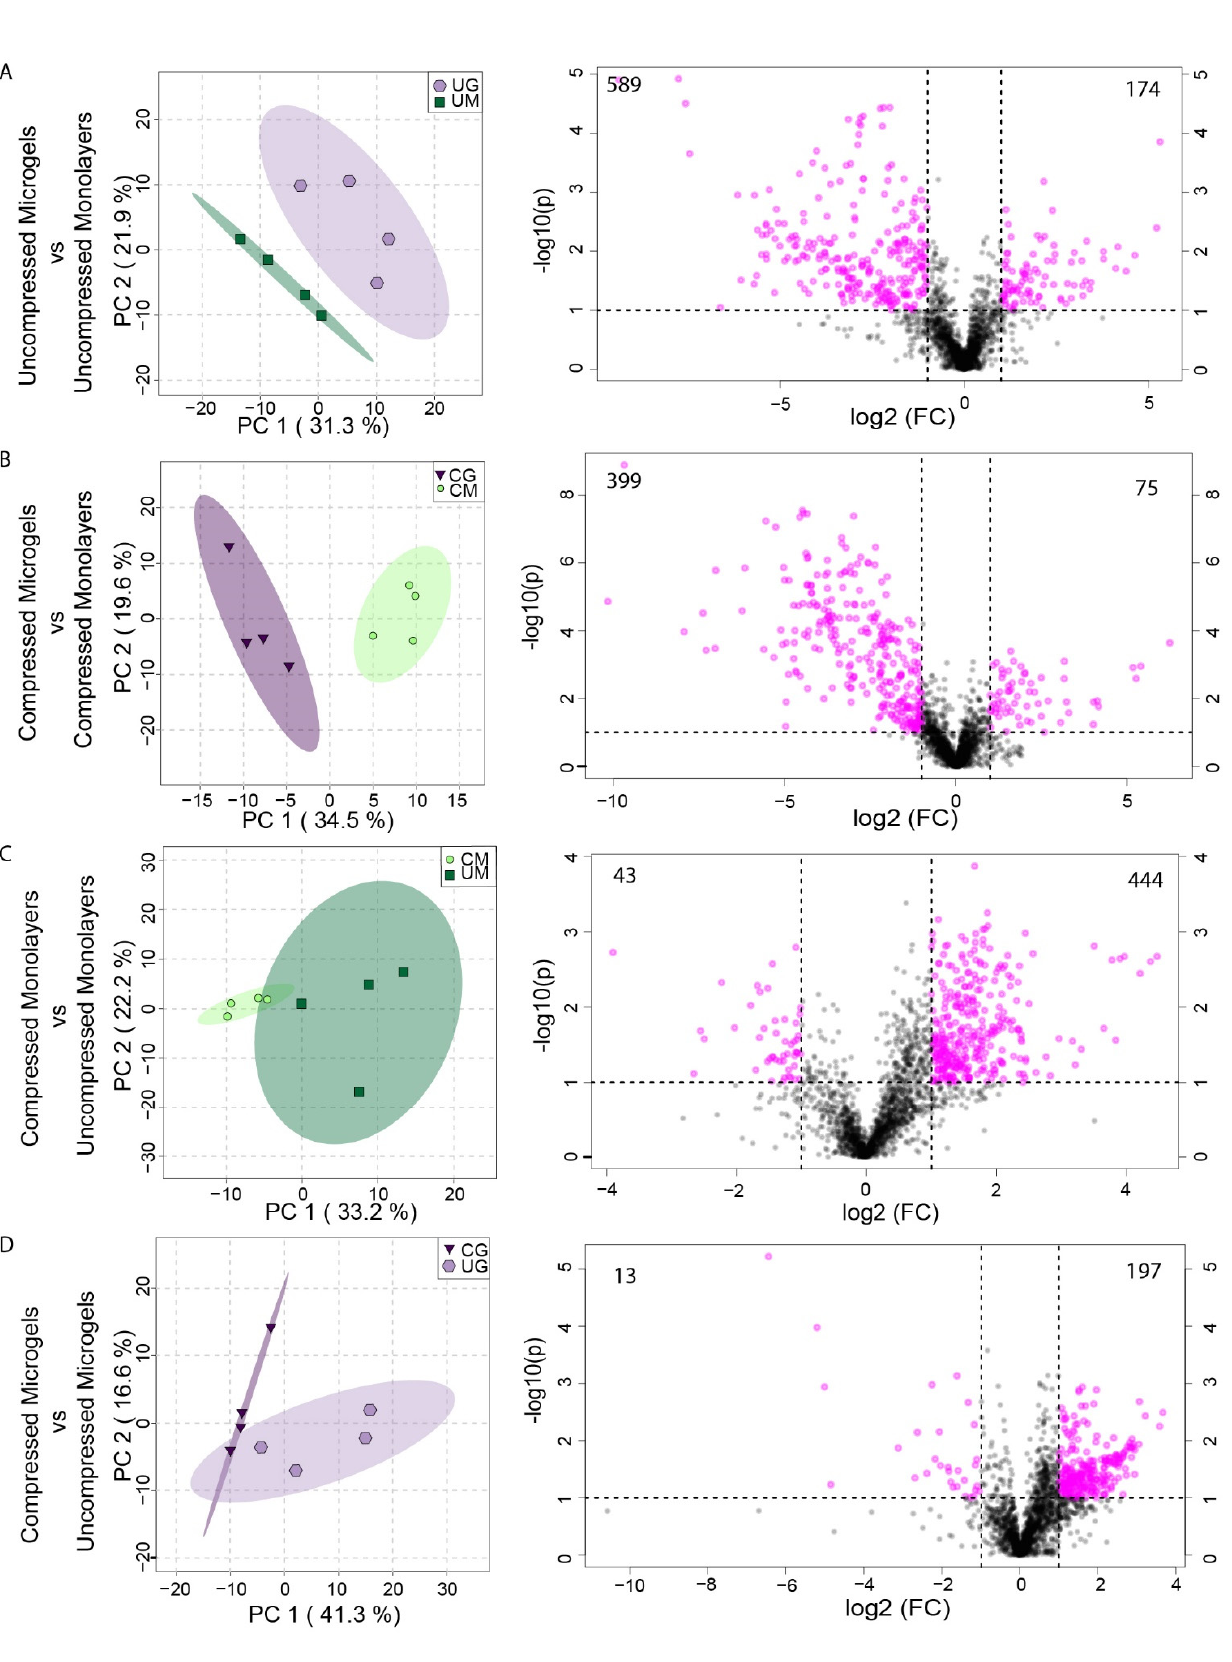
Figure 5. Two-dimensional score plots for PCA analysis (left) and volcano plots (right) for metabolites from SW1353 cells. ( A ) Uncompressed Monolayers (UM) vs. Uncompressed Microgels (UG). (B ) Compressed Microgels (CG) vs. Compressed Monolayers (CM). ( C ) Uncompressed Monolayers